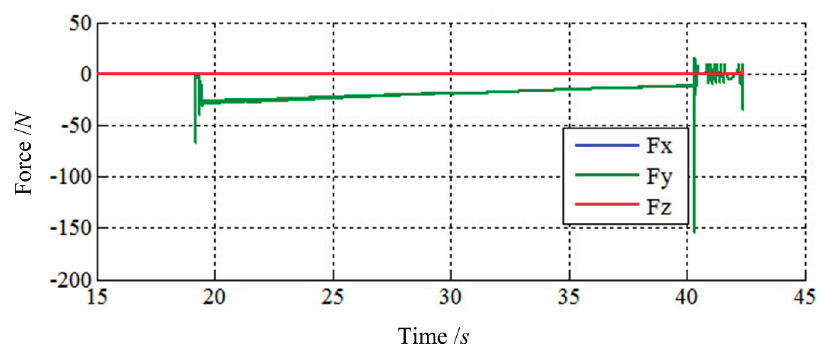
Figure 13. The force tracking results of Case 2.